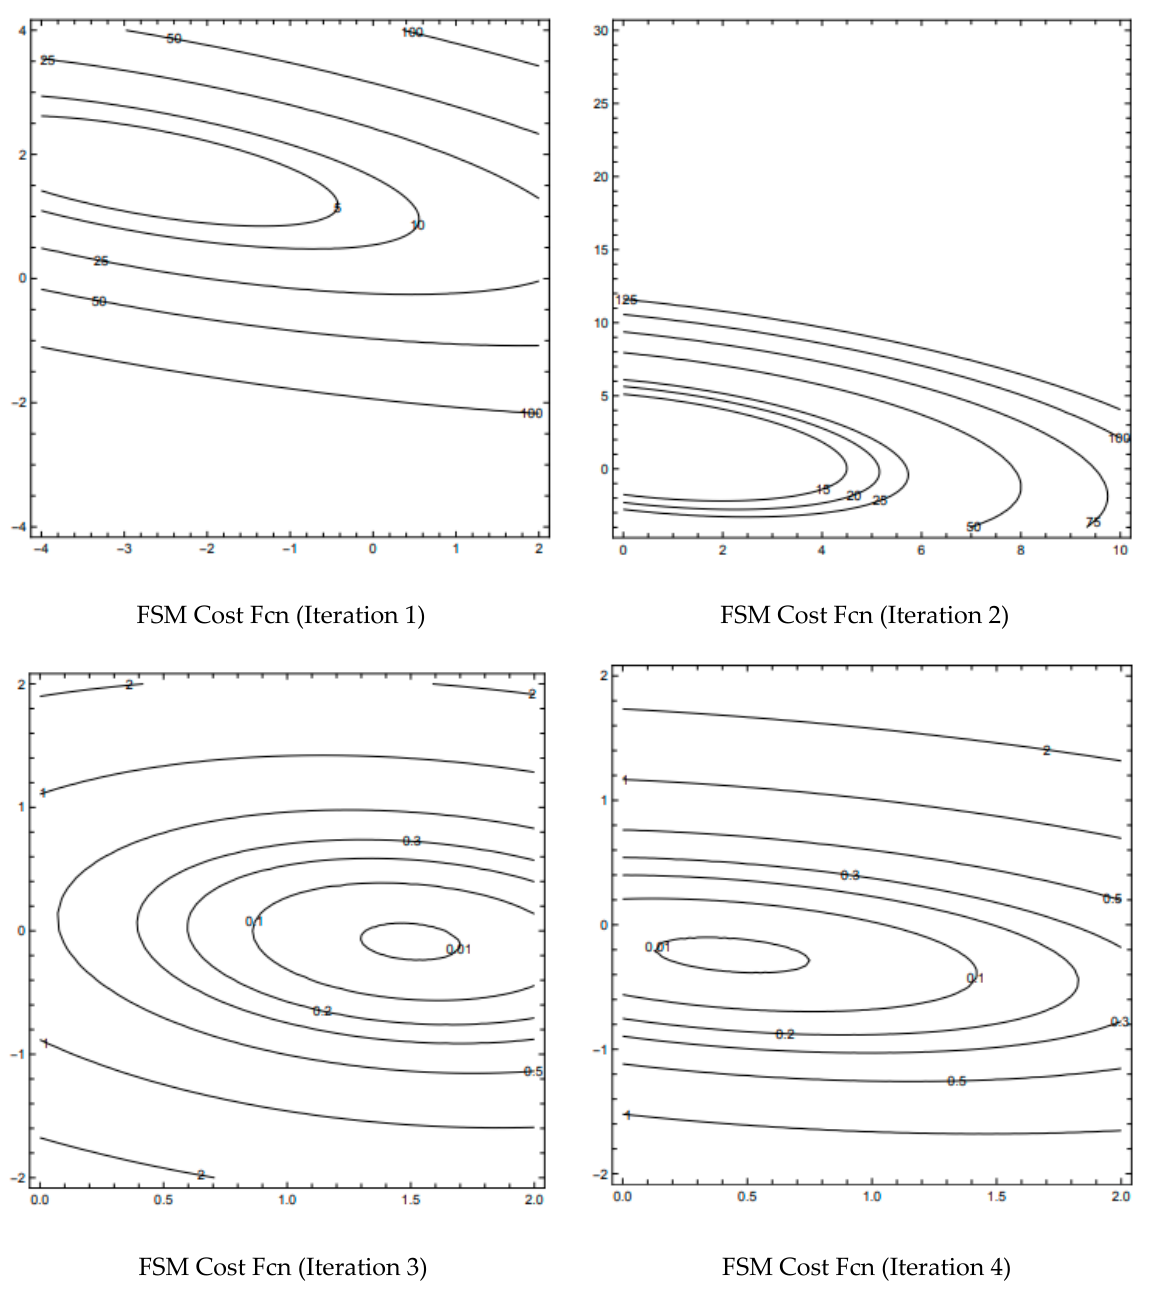
Figure 9. Contour plots of the FSM cost function in the space of control increments ( δλ along the horizontal axis and δσ along the vertical axis). The values of δλ and δσ at the cost function minimum are the incremental adjustments to controls at the operating point.